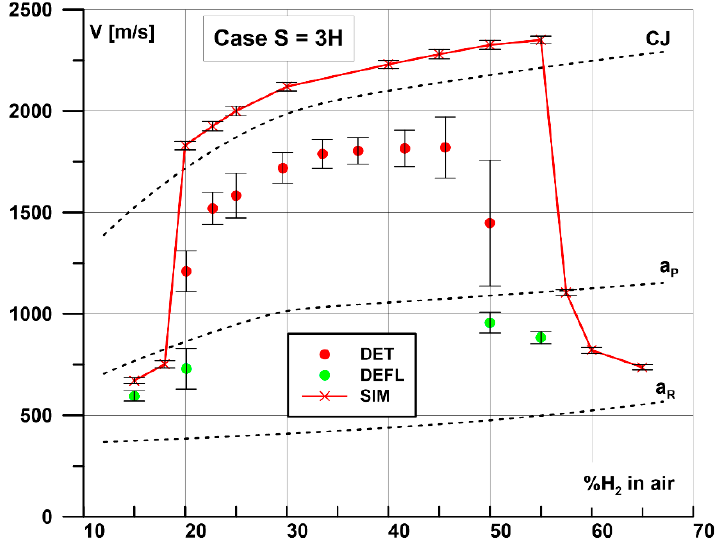
Figure 16. Propagation velocity as a function of mixture composition for S = 3H. Simulation results (line) and experimental results (dots) [31].